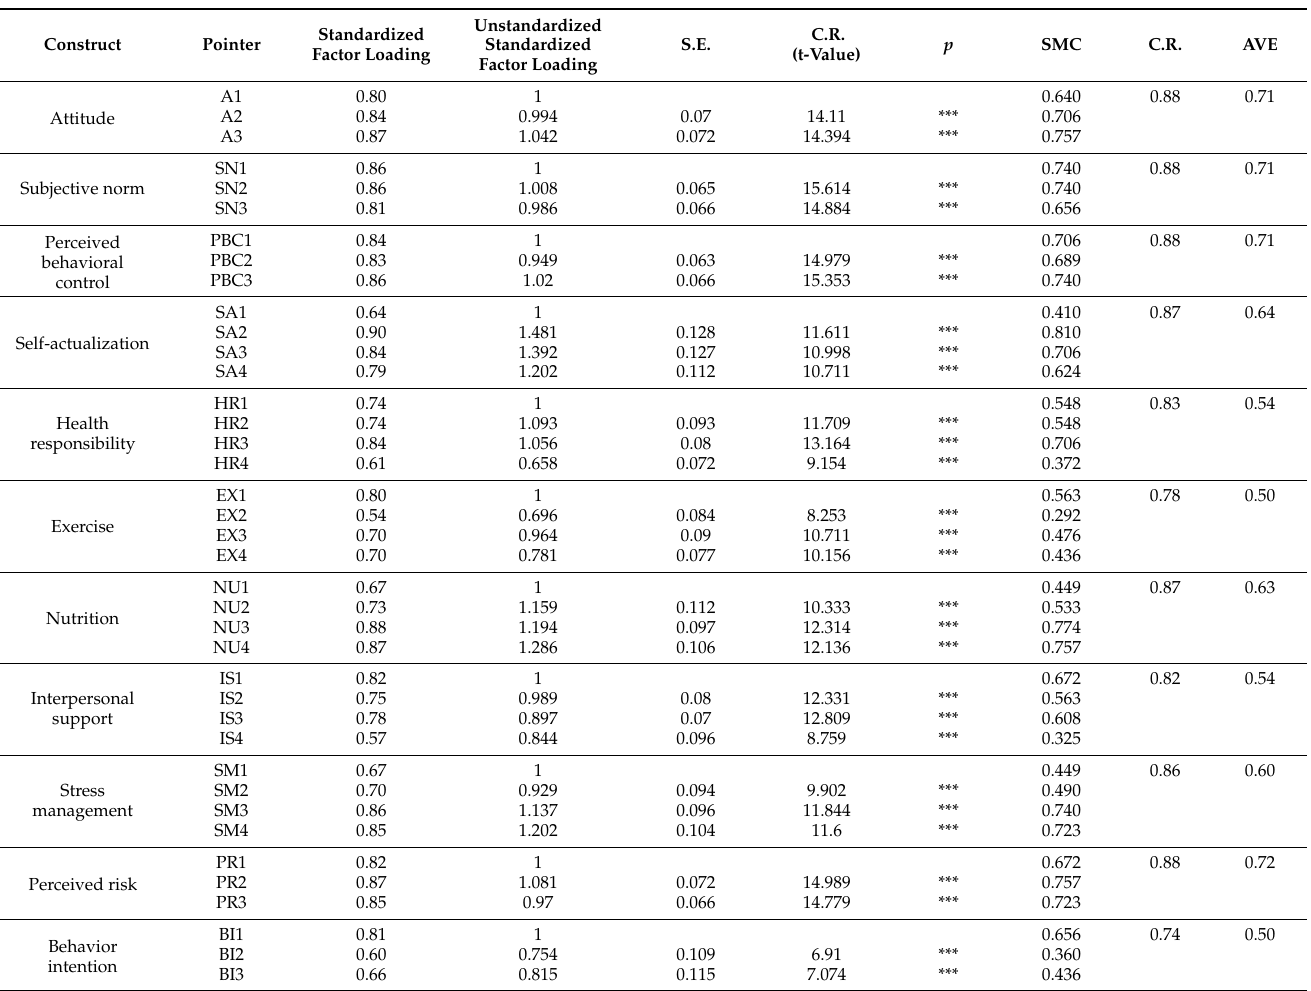
Table 4. The verification analysis of facets.